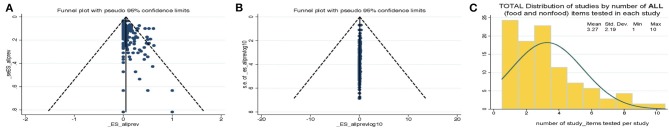
Funnel plot analysis of C. difficile prevalence reports and distribution of studies by the number of food items tested per study. Funnel plots for bias. (A) Standard plot of weighted estimated prevalence vs. standard error of estimated prevalence, however, such strategy is misleading toward suggesting there is publication bias when used on proportion based meta-analyses if the reported effects are close to zero (22). (B) Weighted estimated prevalence vs. sample size (22). (C) Histogram. Study distributions categorized based on total number of food/nonfood item categories tested in each study.